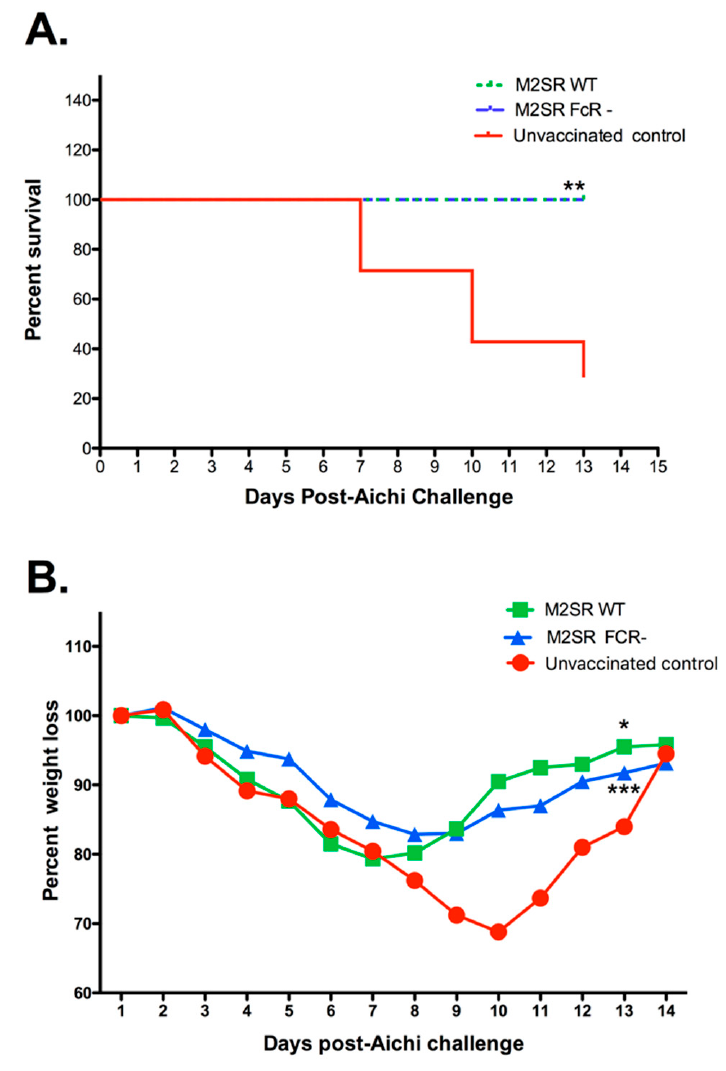
Figure 3. The role of Fc receptors in heterosubtypic immunity induced by M2SR. Wildtype or FcR γ -deficient mice were vaccinated with M2SR and challenged 35 days later with influenza A/Aichi as described in Materials and Methods. Survival ( A ) and body weights ( B ) were monitored for 14 days after challenge. ( A ). There was no significant difference in survival between vaccinated FcR γ -deficient and wildtype mice, while both groups showed a significant difference in survival from the unvaccinated control group (** p < 0.01, Mantel–Cox log rank test). ( B ). There was no significant difference in weight loss following heterosubtypic challenge between M2SR-vaccinated wildtype and FcR γ -deficient mice. However, weight loss in both M2SR-vaccinated wildtype and FcR γ -deficient mice was significantly different from that in unvaccinated wildtype mice (* p < 0.05 and *** p < 0.001, respectively, Paired t test).